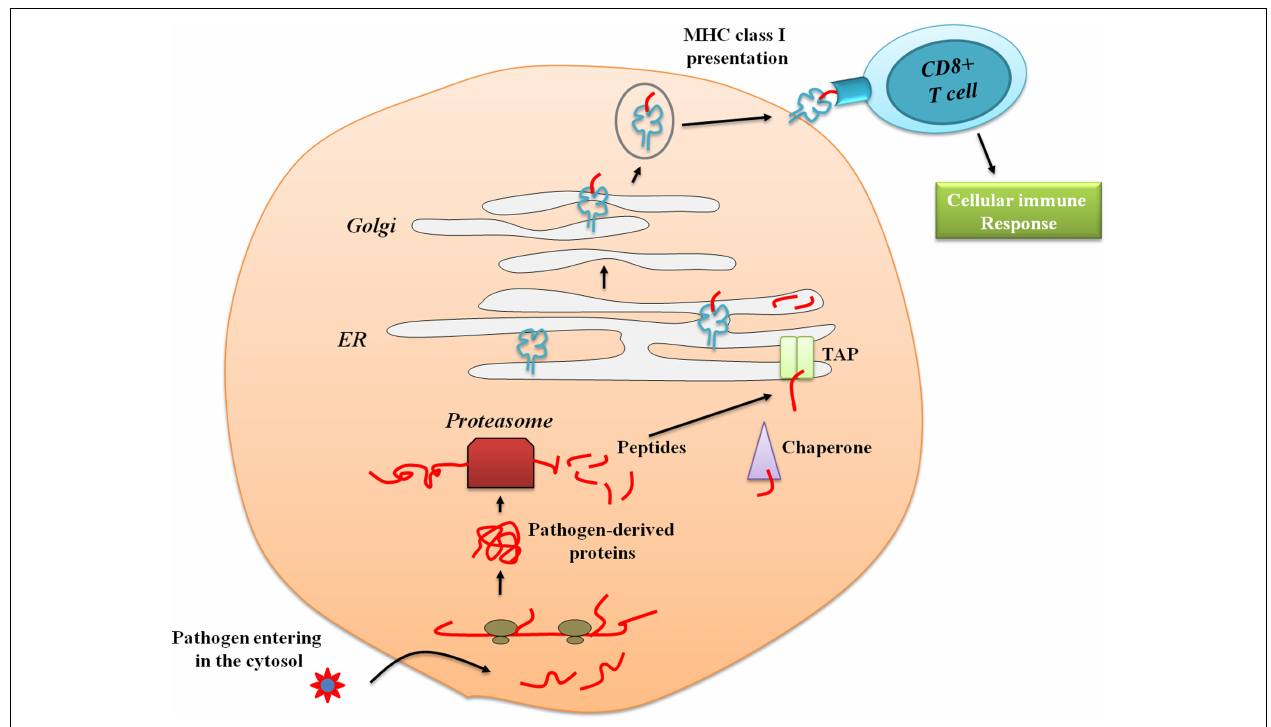
endoplasmic reticulum (ER). In the ER lumen, peptides bind to MHC class I molecules, which are subsequently transported via the Golgi to the plasma membrane.The endogenous antigen presented by MHC class I will then be recognized by the CD8 + T cells leading to adaptive cellular immune